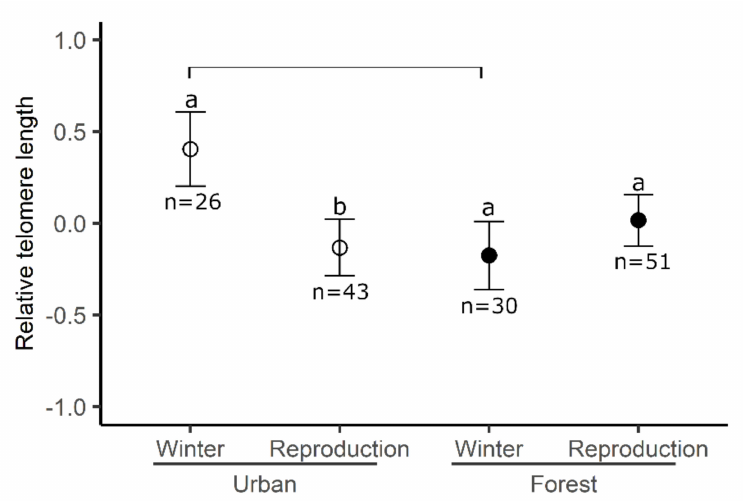
Figure 2. The relative telomere length of birds between sites across seasons. Means and standard errors are represented. Different letters represent significant differences between seasons for the same site and bars represent the difference between sites for the same season (see text for